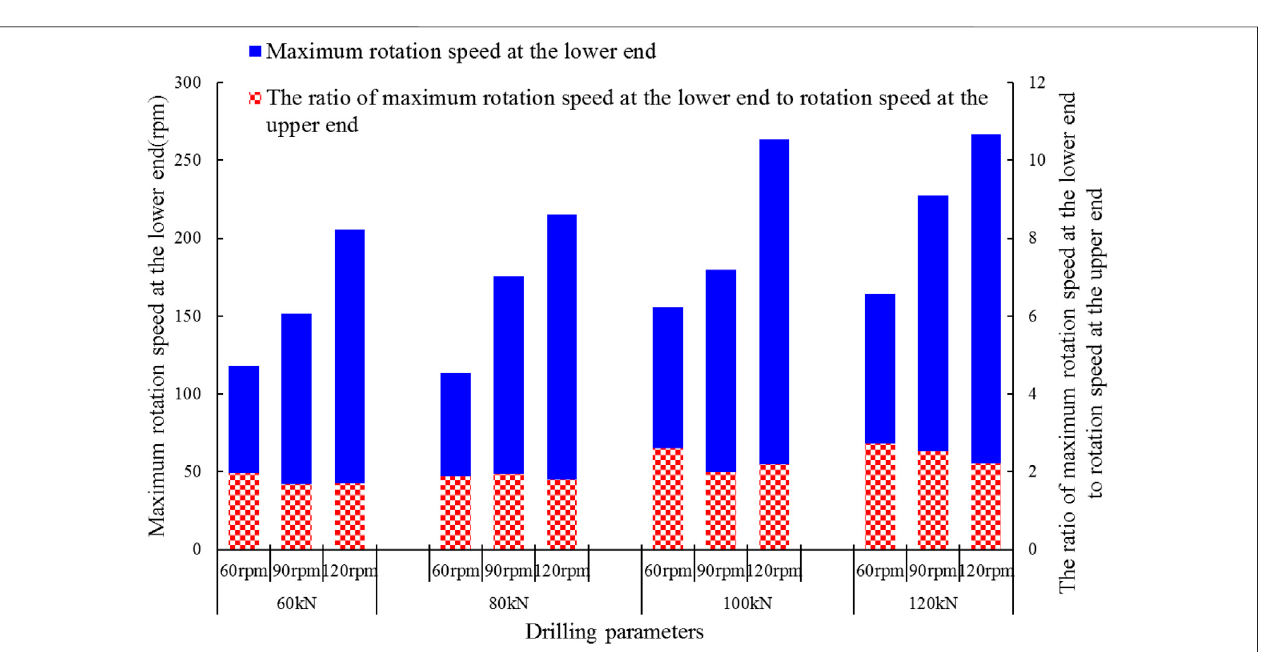
Frontiers in Earth Science |